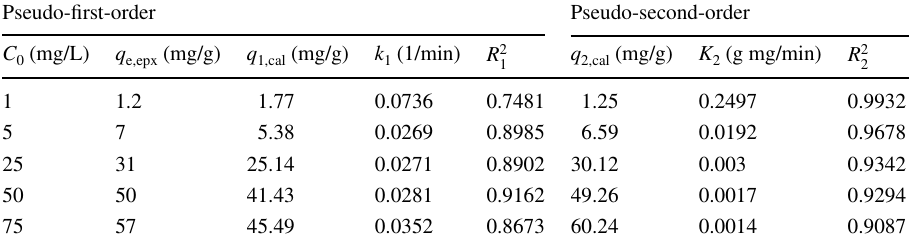
Pseudo-first-order